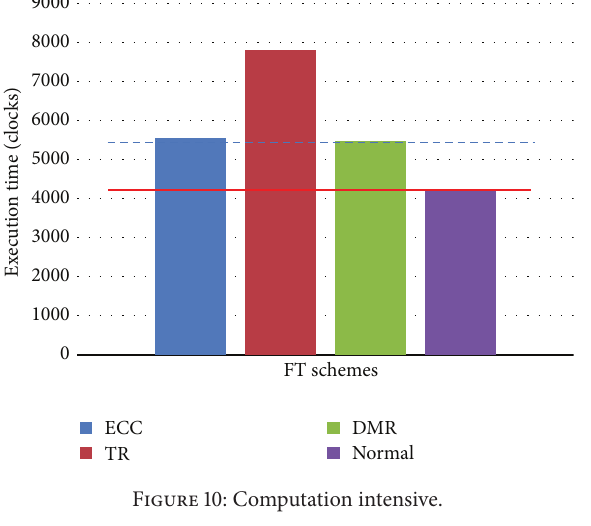
Figure 10: Computation intensive.